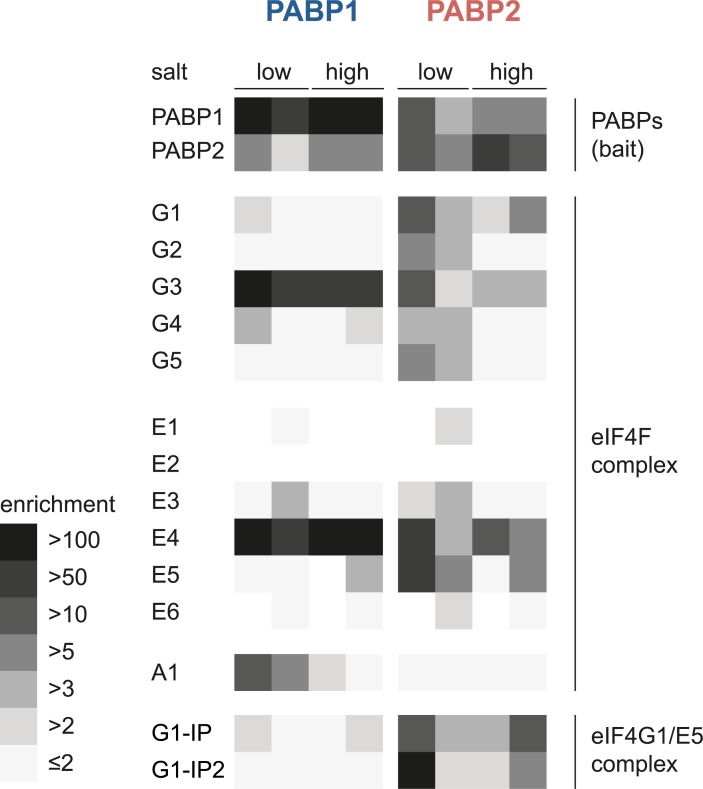
Interactions between PABPs and proteins involved in translation initiation.For each paralog of the eIF4F complex, the two PABPs and the two known interactors of the eIF4G1/eIF4E5 complex [41] the enrichment ratios from all four individual PABP pull-down experiments (low and high salt buffer) are illustrated by a heat map. No square is shown if the protein was not detected in the respective PABP pull-down replicate.